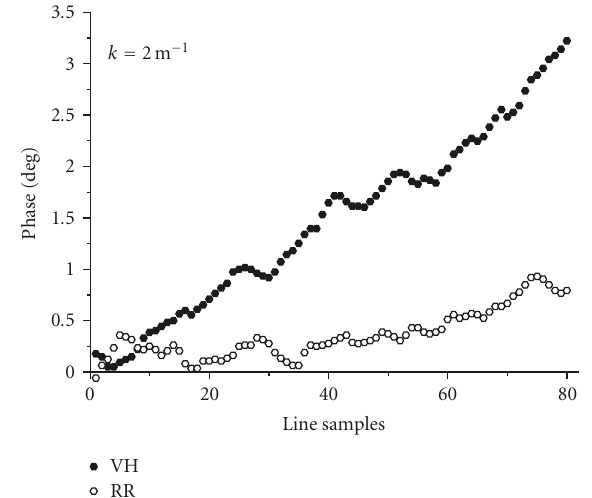
Figure 12: Comparison of the phase drifts obtained by using VH (filled circles) and RR (open circles) schemes in the case of linearly and circularly polarized AM laser light, respectively ( k = 2m − 1 , z T = 1 . 56m, f m =